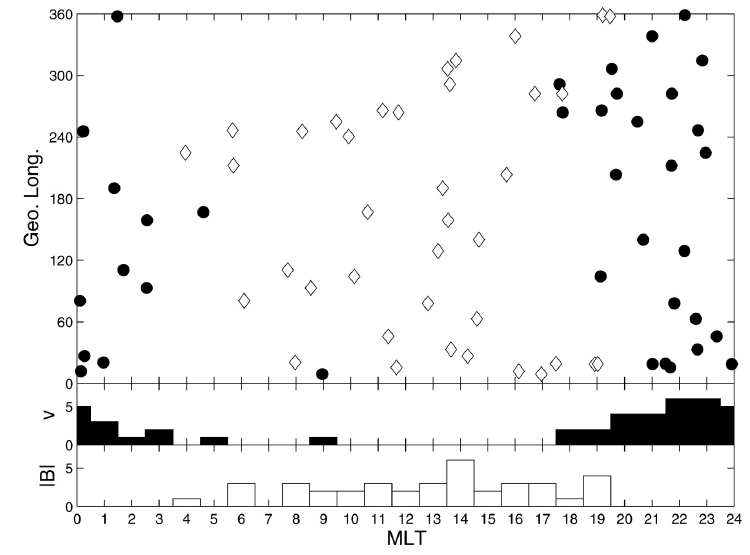
Figure 13: MLT dependence of maximum correlations of ⟨ 𝜎 𝐻 60 ∘ < | Λ | < 82 ∘ . In the top panel, filled circles and open diamonds show the MLT (magnetic local time) – Geographic longitude coordinates of the maximum correlation of ⟨ 𝜎 𝐻 The bottom two panels show the histograms of the MLT of the maxima in the correlations for | 𝑉 SW | (in black) and 𝐵 (in white). Image reproduced by permission from Finch et al. (2008), copyright by